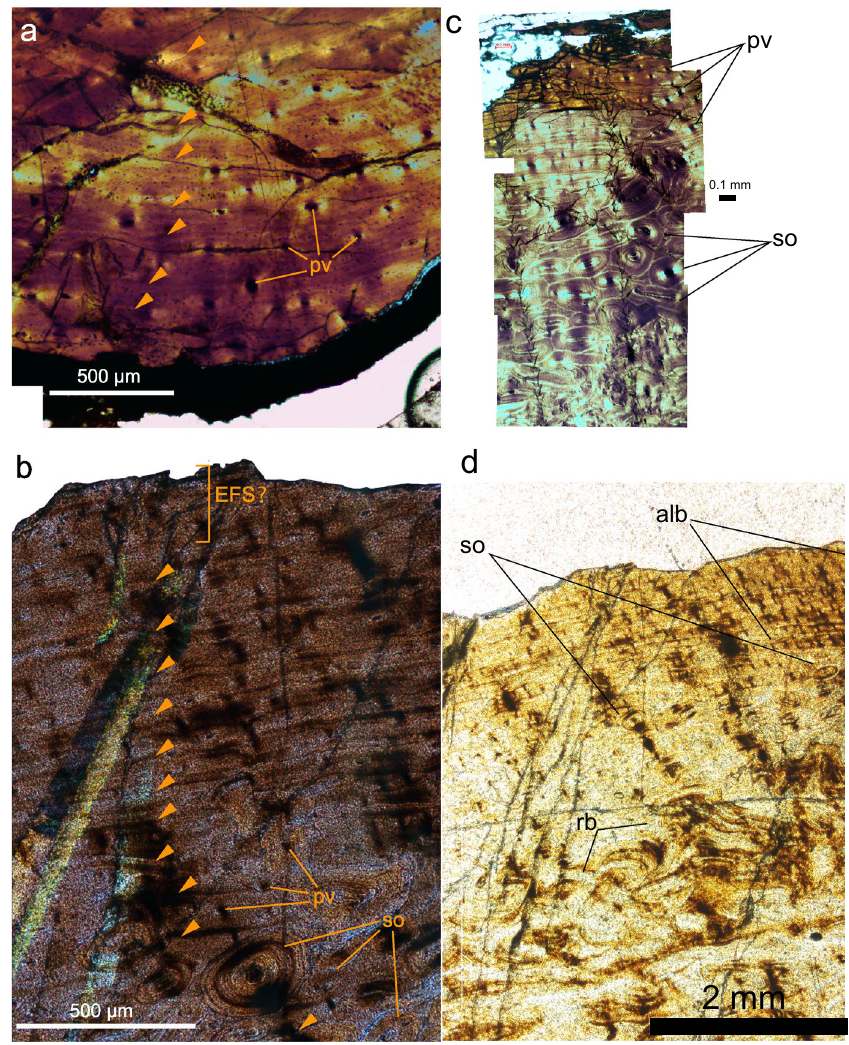
Figure 3. Osteohistology of Tethyshadros insularis revealing the somatically immature status of the holotype ( a ) and the older, potentially somatically mature stage attained by SC 57247 ( b ). Count of lines of arrested growth (LAGs 71 ) is shown in ( a ) and ( b ), while differences in histological texture organisation between the inner cortex and the outer-peripheral margin of the bone are shown in ( c ) for SC 57021 and in ( d ) for SC 57247. Abbreviations: alb, avascular-laminar to sub-parallel-fibered bone tissue; pv, primary vascularity; rb, remodelled bone tissue; so, secondary osteons; EFS?, tentatively identified External Fundamental